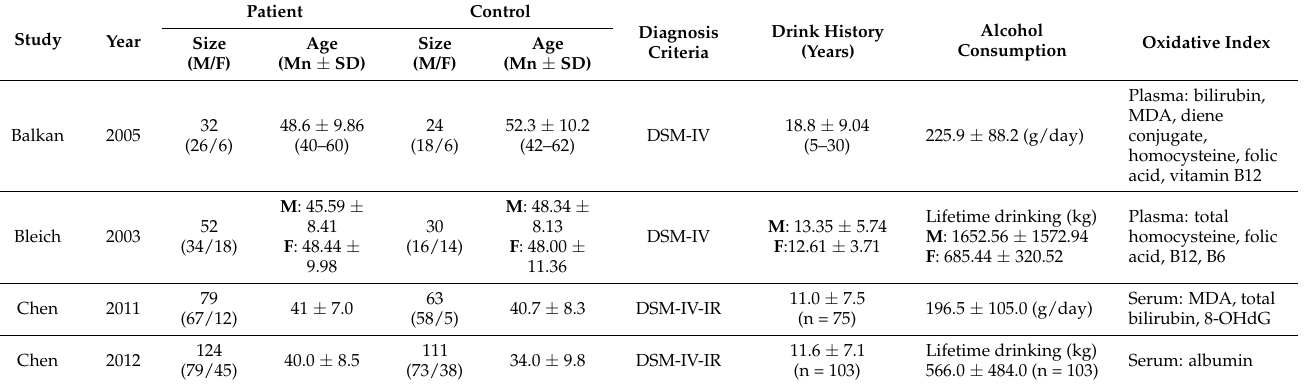
Table 1. Basic information of the included